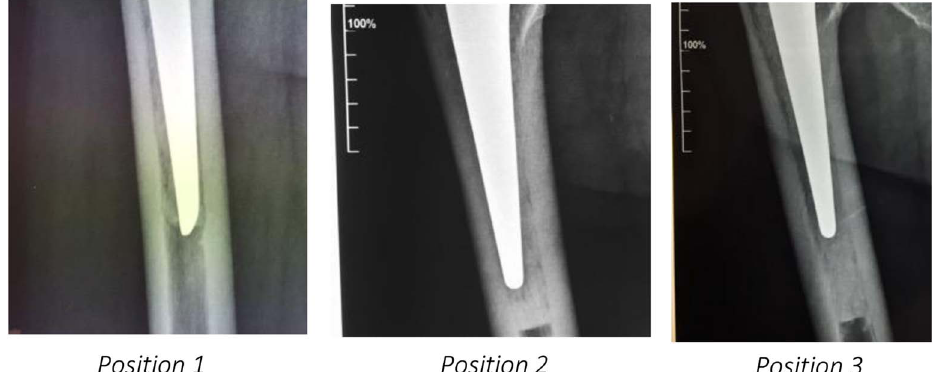
Figure 3. X-ray evaluation of APCR position related to the tip of the